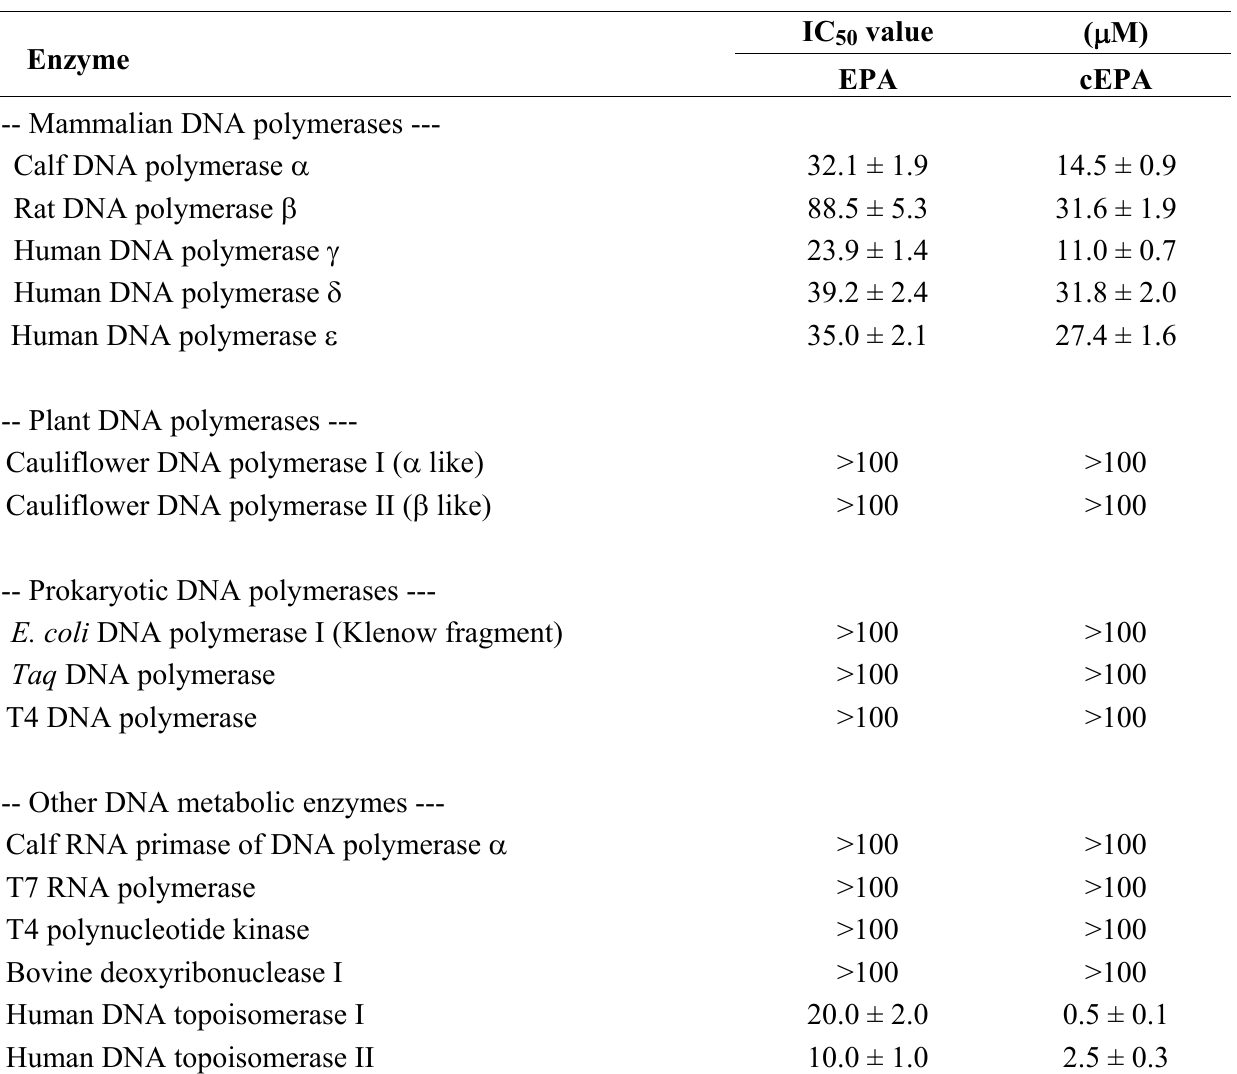
values of EPA and cEPA for the activities of various Table 1. IC 50 DNA polymerases and other DNA metabolic